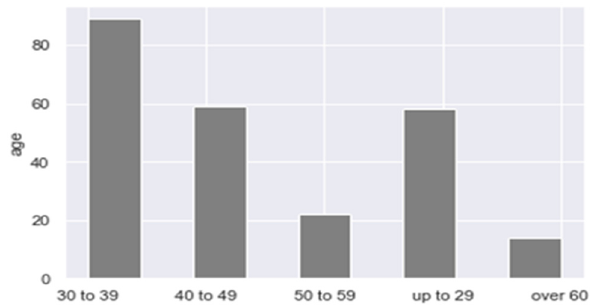
Figure A2. Profile of respondents by age. Source: own research.